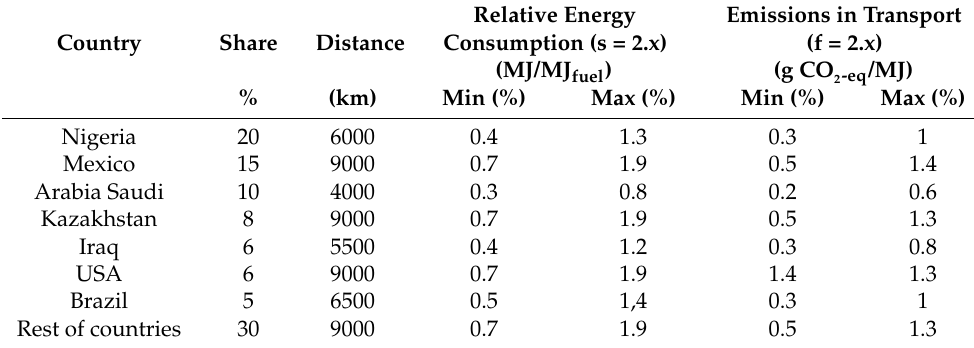
Table 1. Inventory of crude imports to mainland Spain by tankers.